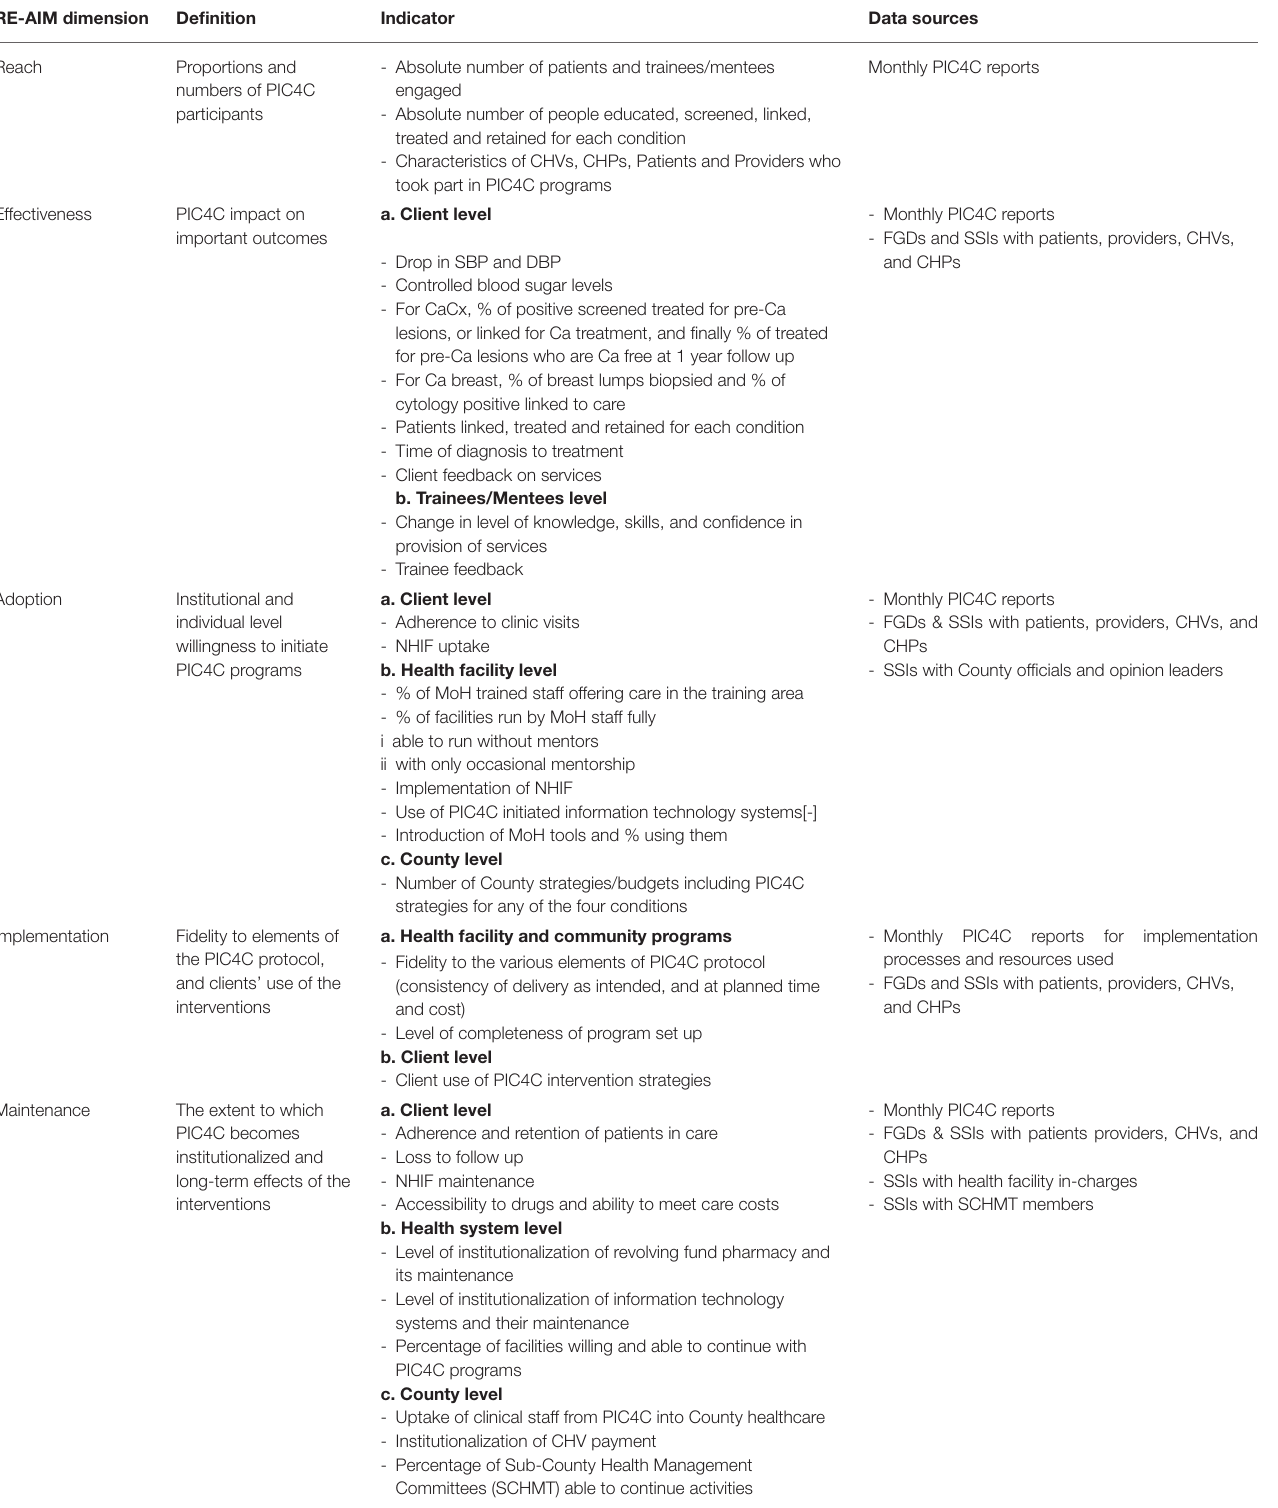
TABLE 3 | PIC4C process evaluation indicators and data sources. RE-AIM